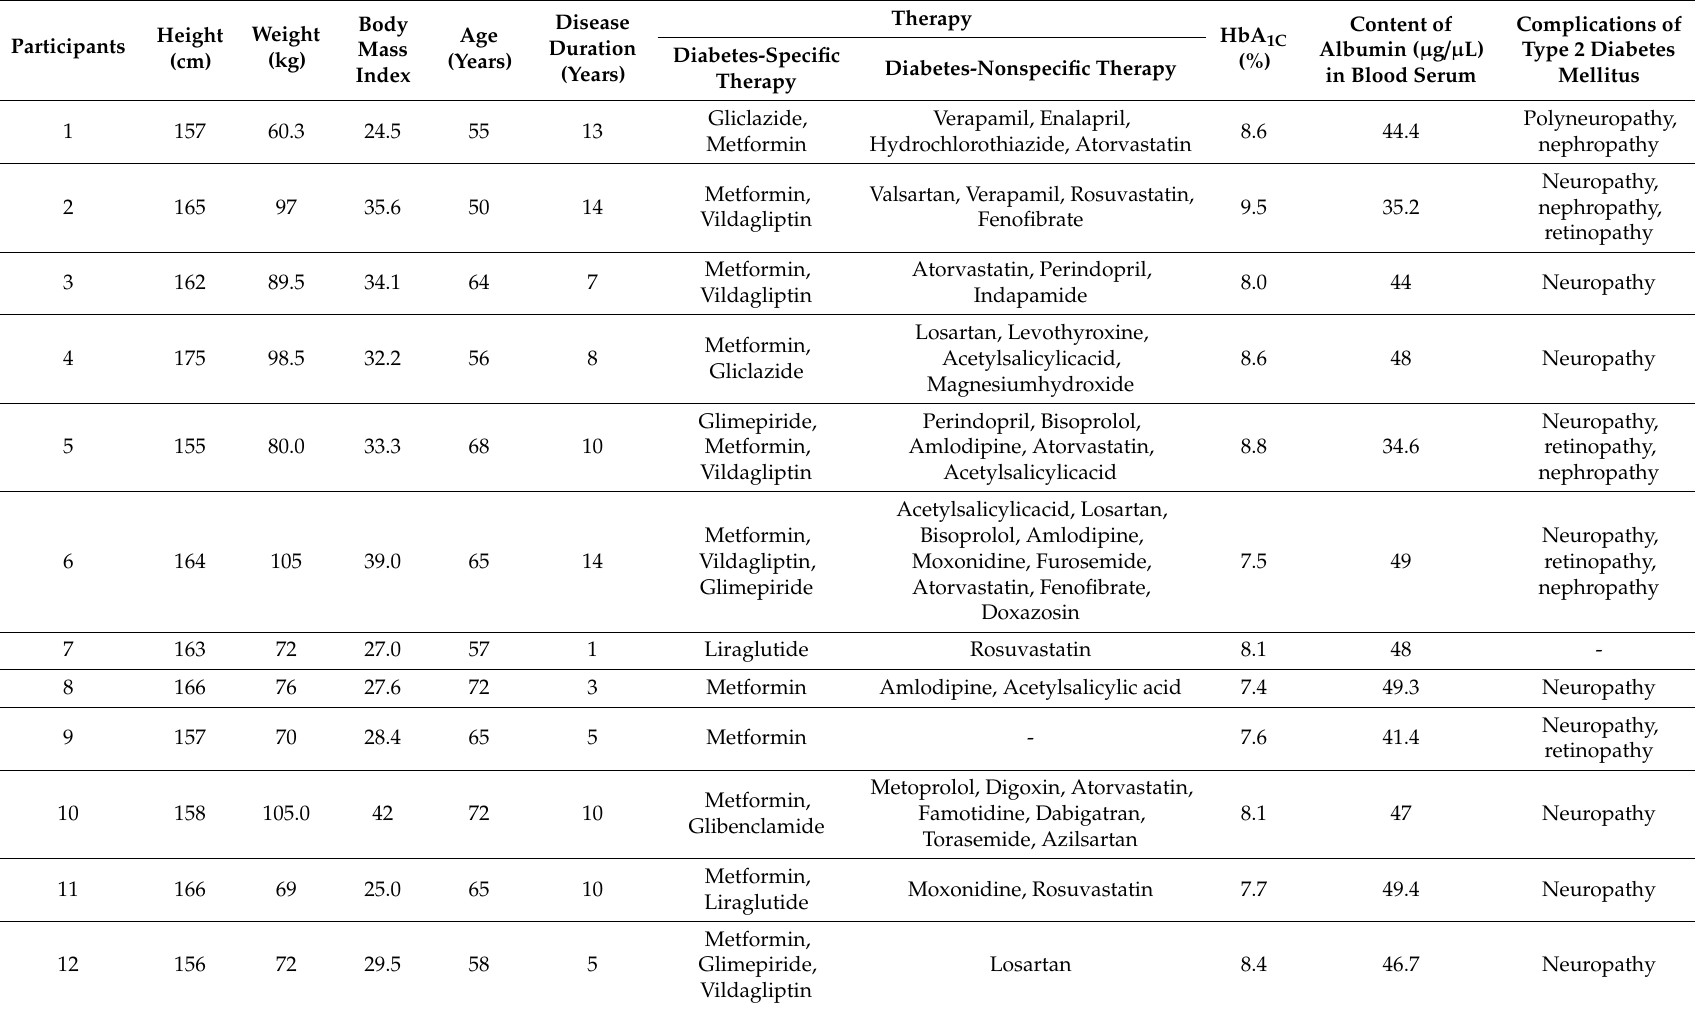
Table 4. Physical and biochemical parameters of the T2DM patients, as well as corresponding diabetes-related and non-related therapy.